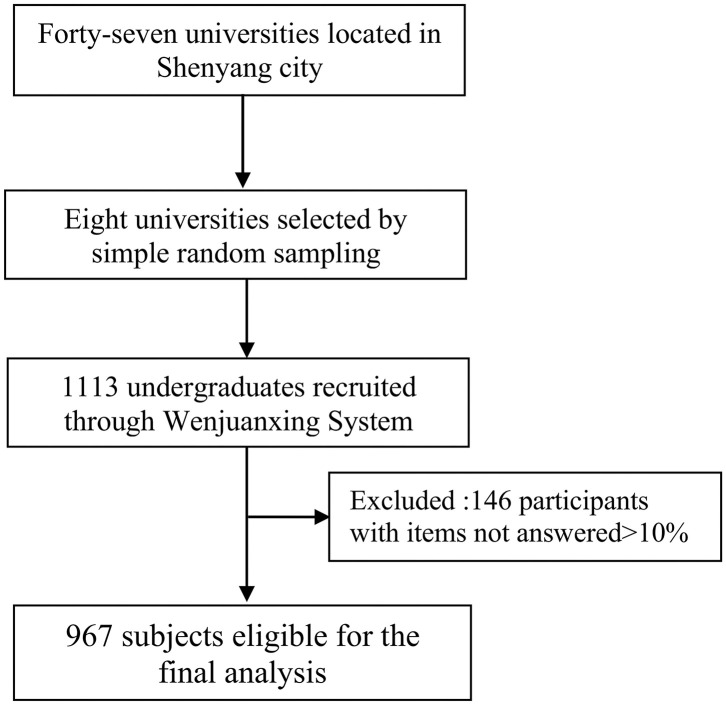
Flow chart for participant selection.